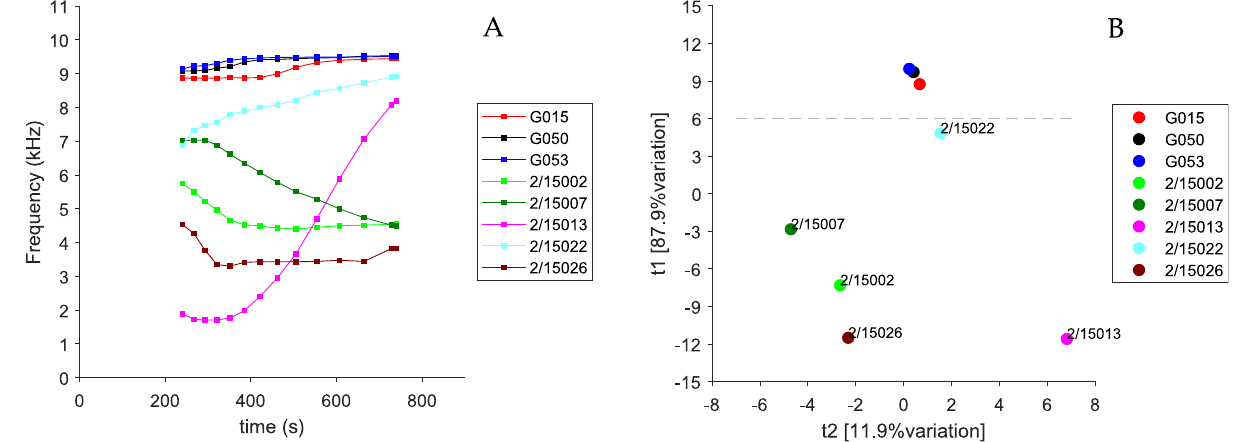
Figure 9. ( A ) BARDS profile time region of comparison across all the artesunate tablets. ( B ) Principle component scores plot for first (t1) and second (t2) principle components, the dashed grey line highlights a potential threshold value to distinguish between genuine and falsified artesunate